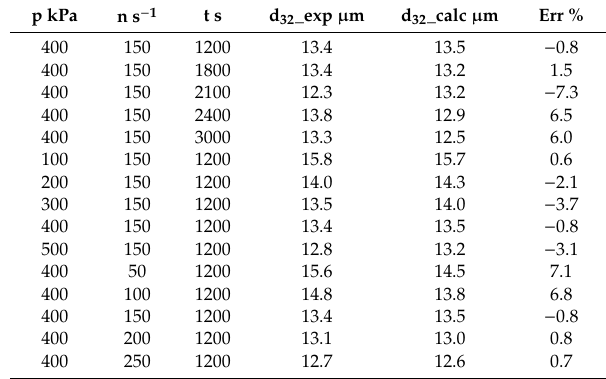
Table A2. Mean Sauter diameter of the product, measured and calculated by FLMill model (SSE = 5.07). p